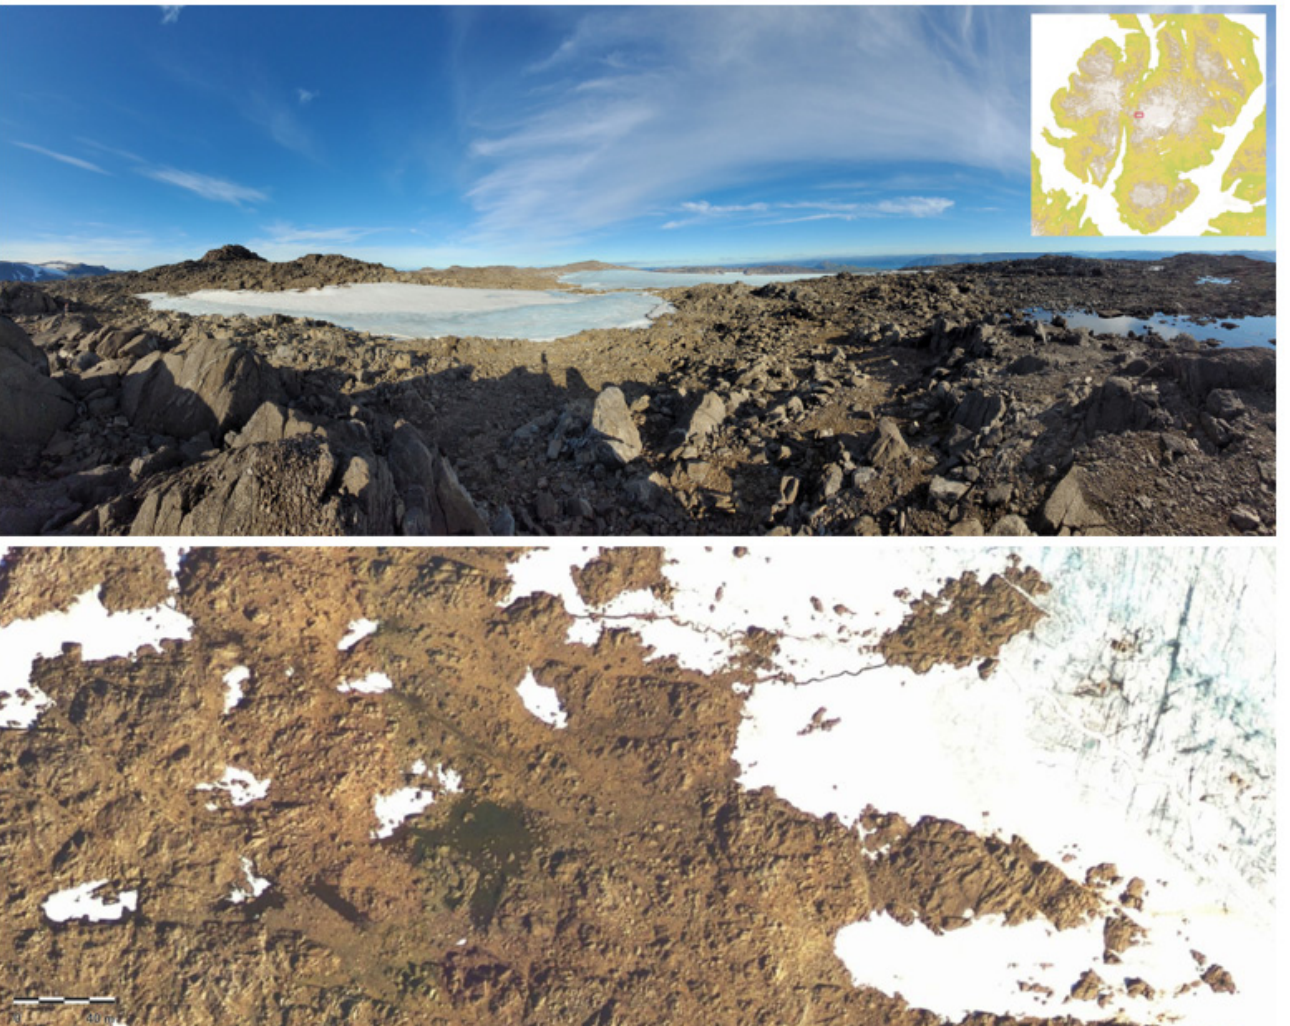
Figure 6. ( top ) The survey terrain close to the glacier on the eastern plateau is extremely rugged and systematic line-walking is almost impossible as the way is blocked by meter-high boulders, meltwater lakes and snow patches which are undercut by water (photograph by G. Caspari); ( bottom ) Aerial orthophotograph by the Norwegian Mapping Authority.